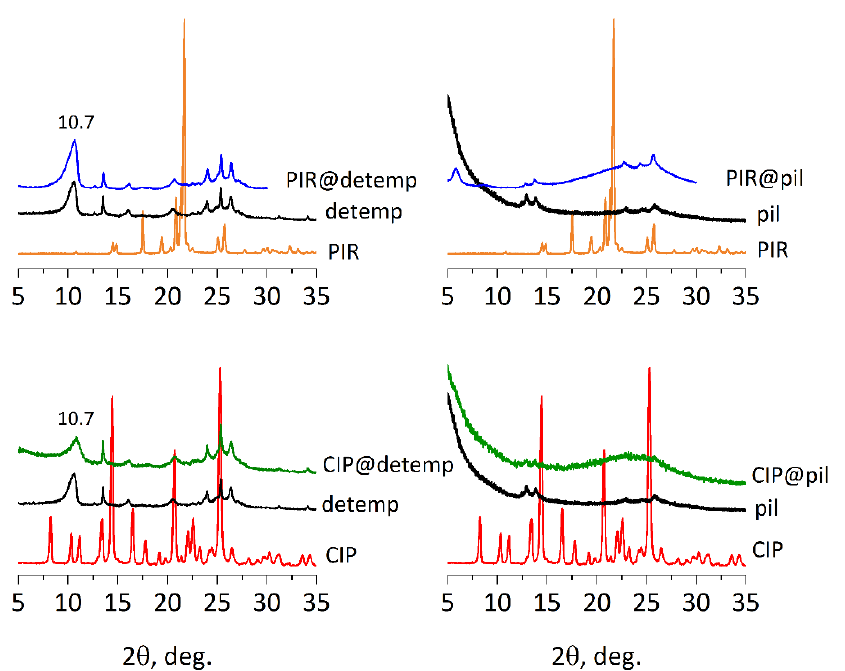
Figure 3. XRD patterns for detemplated (detemp) and pillared (pil) ZSM-55 intercalated with piracetam (PIR) and ciprofloxacin (CIP). Table 1. Basic textural parameters for detemplated and pillared ZSM-55. External surface area (S ext ) and pore volume (V T-plot ) were calculated by the t-plot method, combining micropores and small